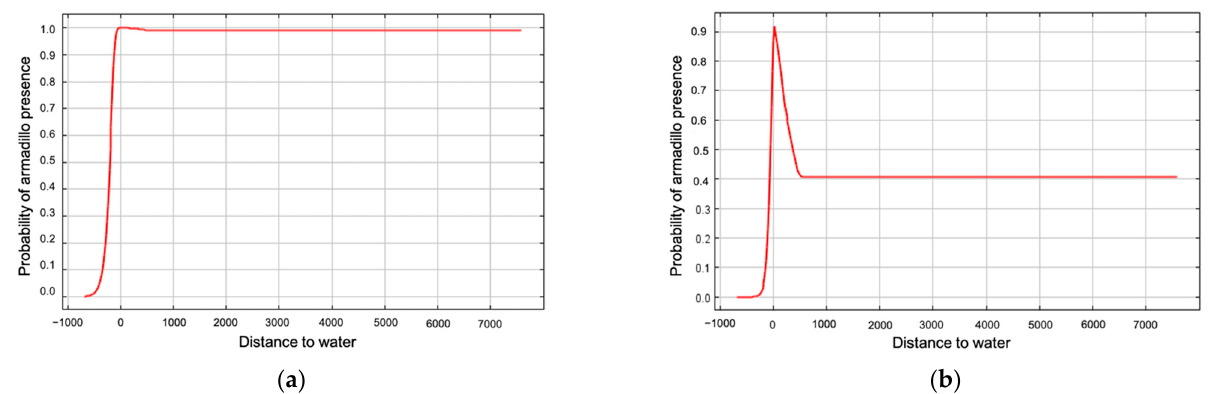
Figure 6. Marginal response curve ( a ) and response curve using only the corresponding variable ( b ) for distance to water as an environmental predictor for presence of nine-banded armadillos in southern Illinois during 2016–2020. Probability of armadillo presence was higher when closer to water.